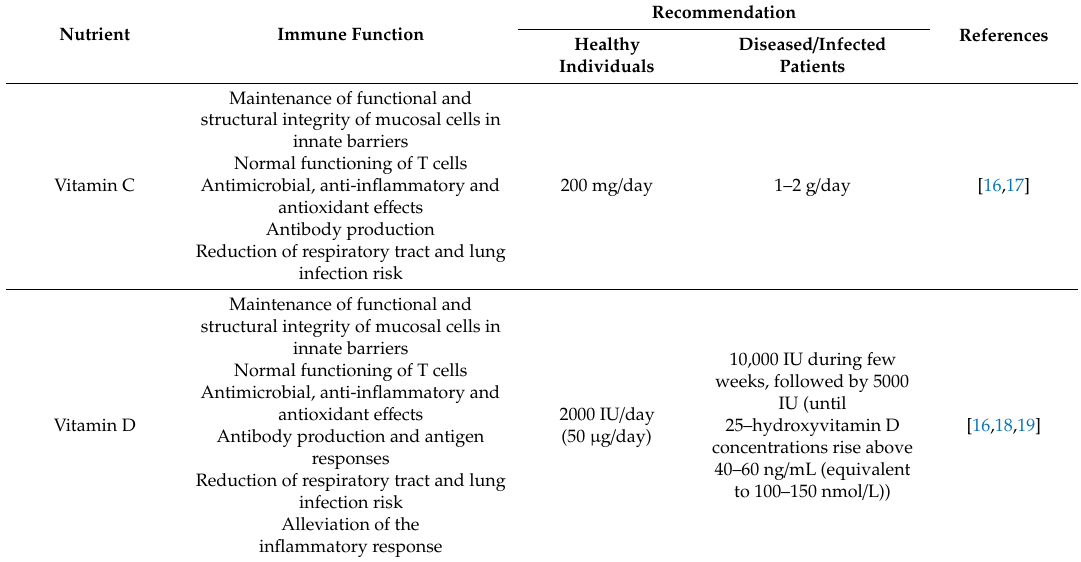
Table 1. Recommended intakes of certain nutrients with key roles in disease susceptibility and the maintenance of an adequate immune